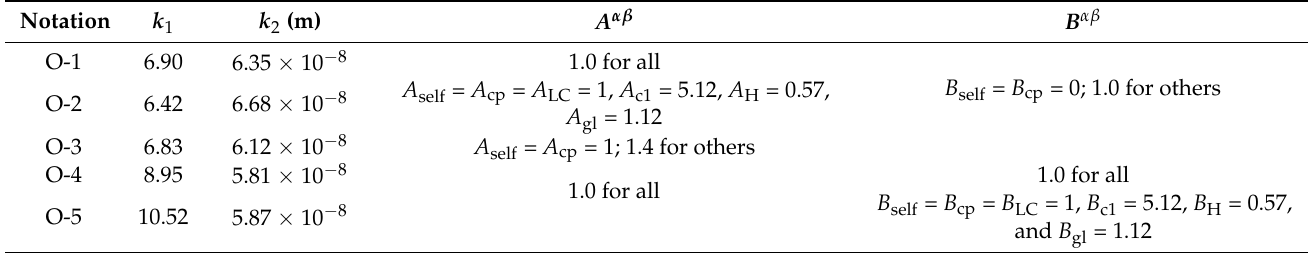
Table 2. Material parameters in crystal plasticity simulation for the O